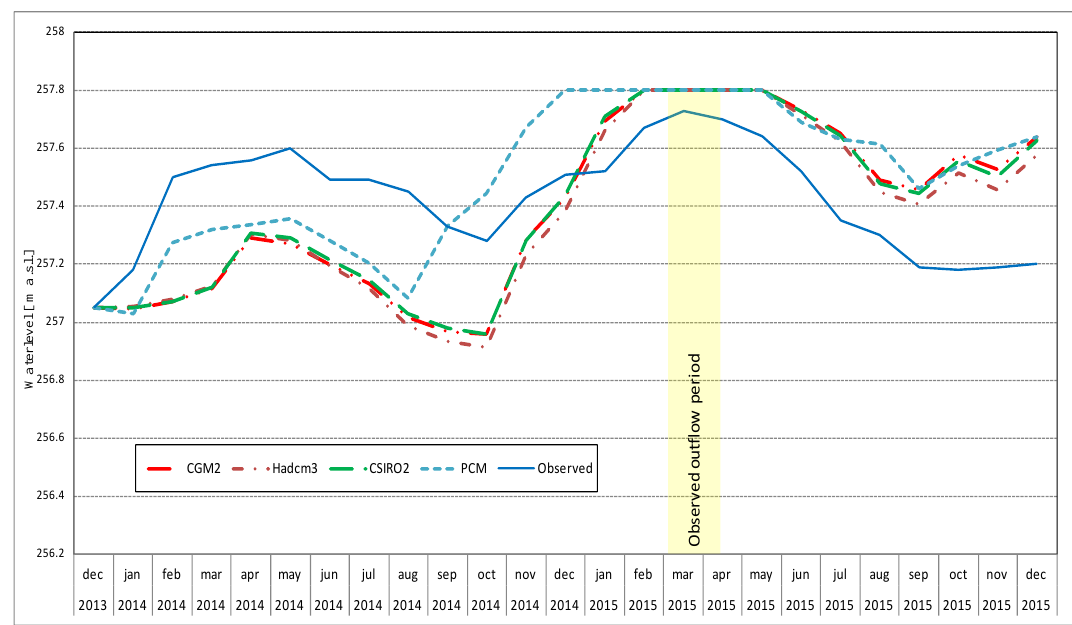
Figure 12. Lake Trasimeno levels observed and simulated in scenario A1F1, test period.